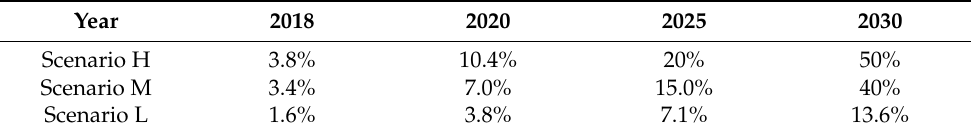
Table 1. The passenger car market hypothesis: market share of NEV. NEV: New Energy